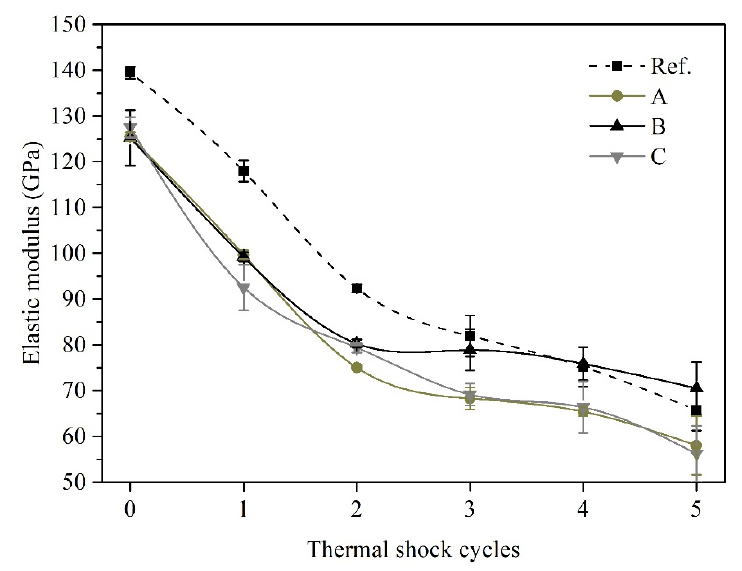
Figure 7. The variation of elastic modulus of castables with thermal shock cycles. E and E 0 refer to the elastic modulus after and before the thermal shock, respectively.